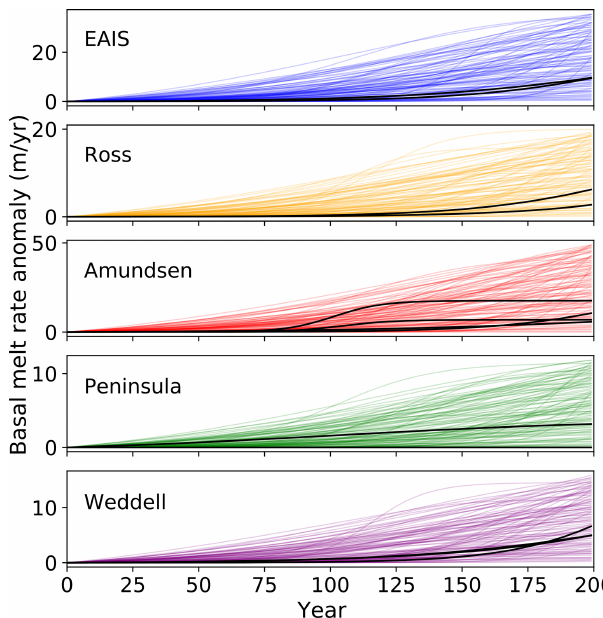
Figure 6. Sample of 100 Sobol’-generated melt rate trajectories (colors) and best fits (by least-squares optimization) to ocean model data from Timmermann and Hellmer (2013) and Cornford et al. (2015) overlaid in black for each basin. By definition, the Sobol’- generated curves are permitted to sample up to the maximal melt values given in the text, representing roughly twice the maximum “data” melt rate at year